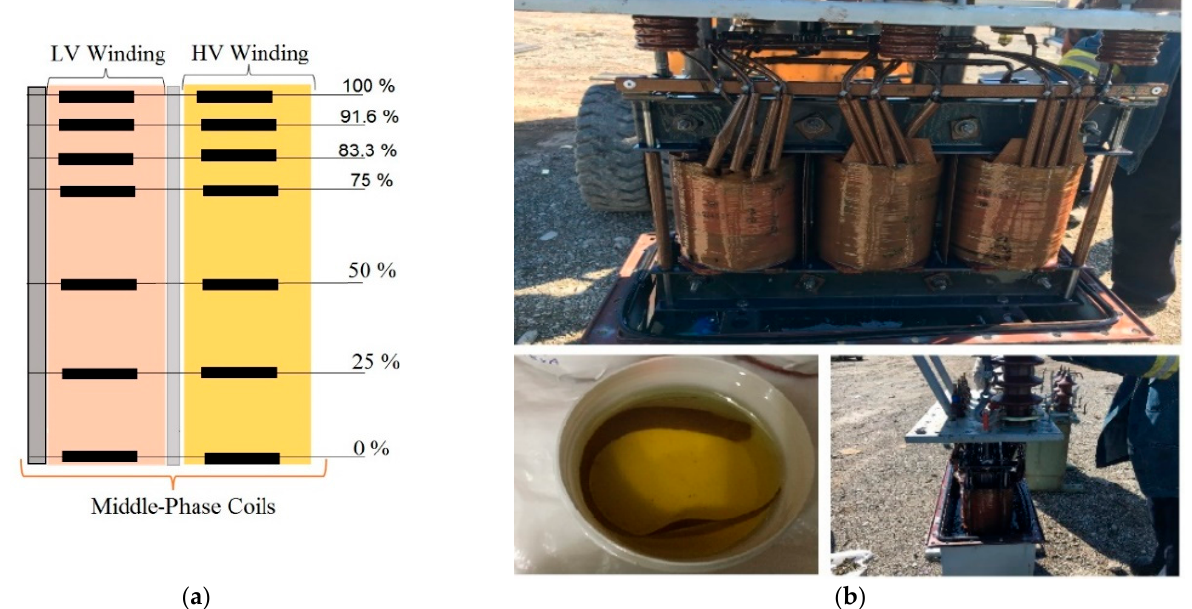
Figure 2. ( a ). Illustration of the sampling points on a coil; ( b ). View of overhauled transformer and samples of paper col- Figure 2. ( a ) Illustration of the sampling points on a coil; ( b ) View of overhauled transformer and samples of paper collected lected for testing the DP. for testing the